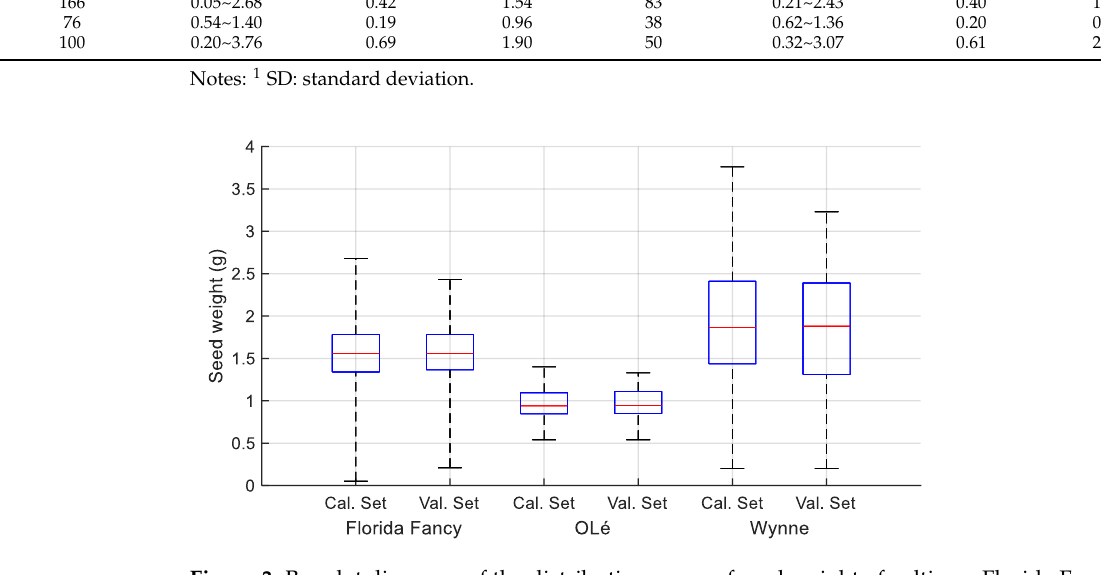
Figure 3. Boxplot diagrams of the distribution range of seed weight of cultivars Florida Fancy, OLé, and Wynne.